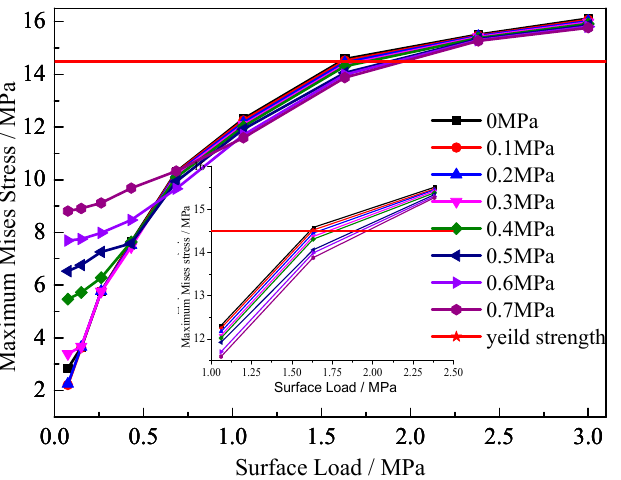
Figure 13. Maximum von Mises stress in HDPE pipe under different internal pressure loads.